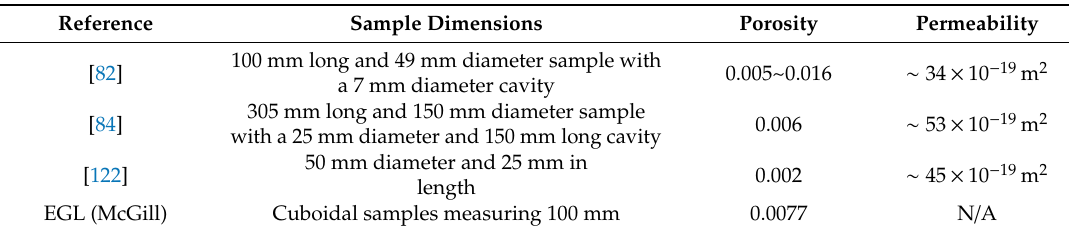
Table 5. Permeability estimates for the Stanstead